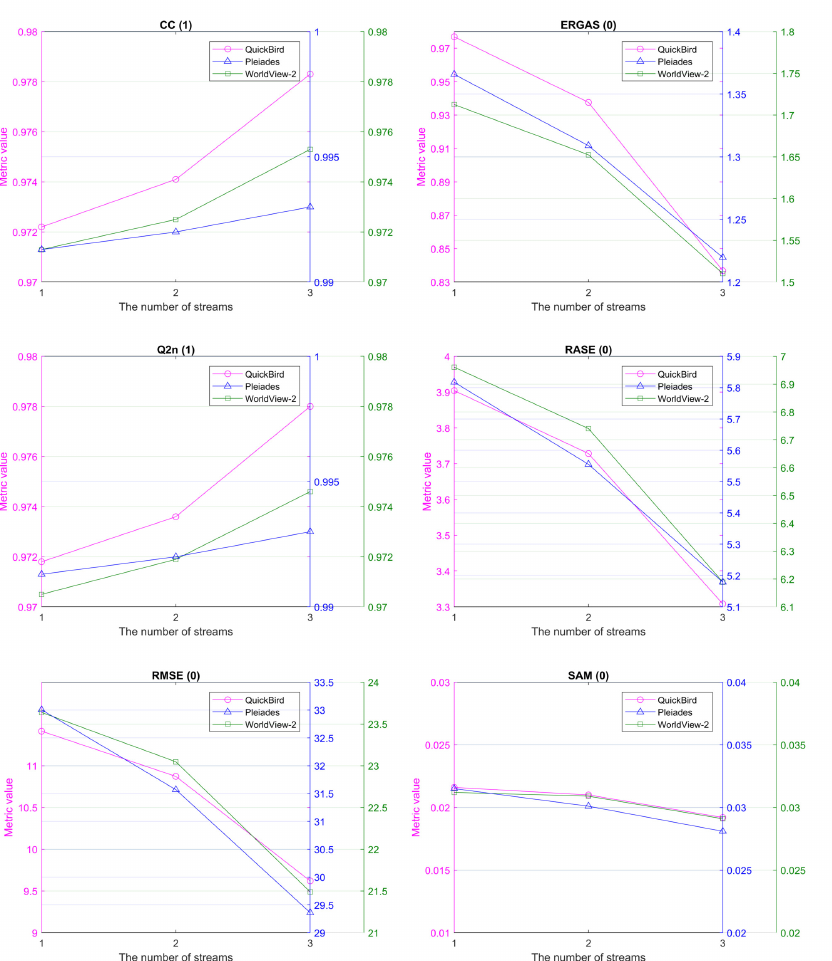
Figure 11. Quantitative fusion results by varying the number of streams on the three real remote sensing datasets.